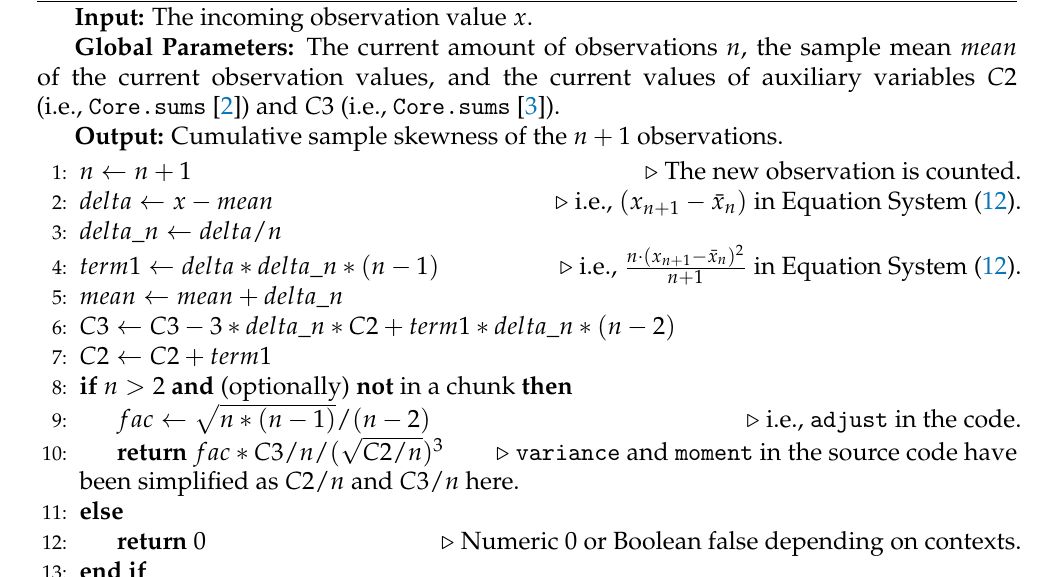
Algorithm 2 Cumulative Sample Skewness in